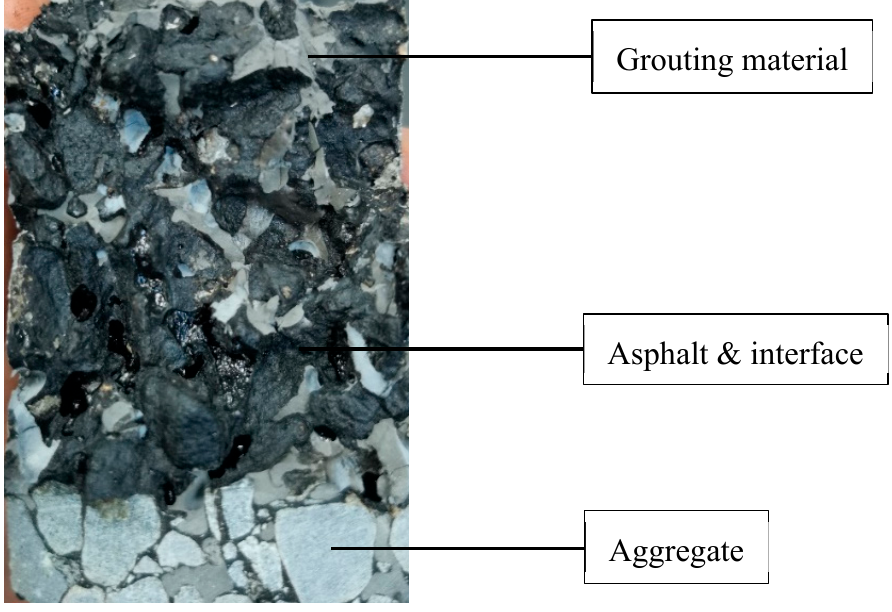
Figure 1. Fracture surface of the SCB fatigue test. The original image was rotated and cut to get the fracture surface area, then it was binary processed by MATLAB [33]. Black pixels and white pixels represent the asphalt phase and grouting material, respectively, and their proportion in the total image pixels was calculated. The calculated results can be used to analyze the similarities and differences of the SFP fatigue failure process under different conditions, so as to further analyze the fatigue failure mechanism of the SFP. The fracture surface image was randomly selected to determine the binarization threshold. As shown in Figure 2, the best effect was achieved by selecting the calculation result of gray thresh function of MATLAB plus 0.15 as the threshold. This threshold calculation method can reduce the errors caused by material reflection, camera aperture size, exposure time and so